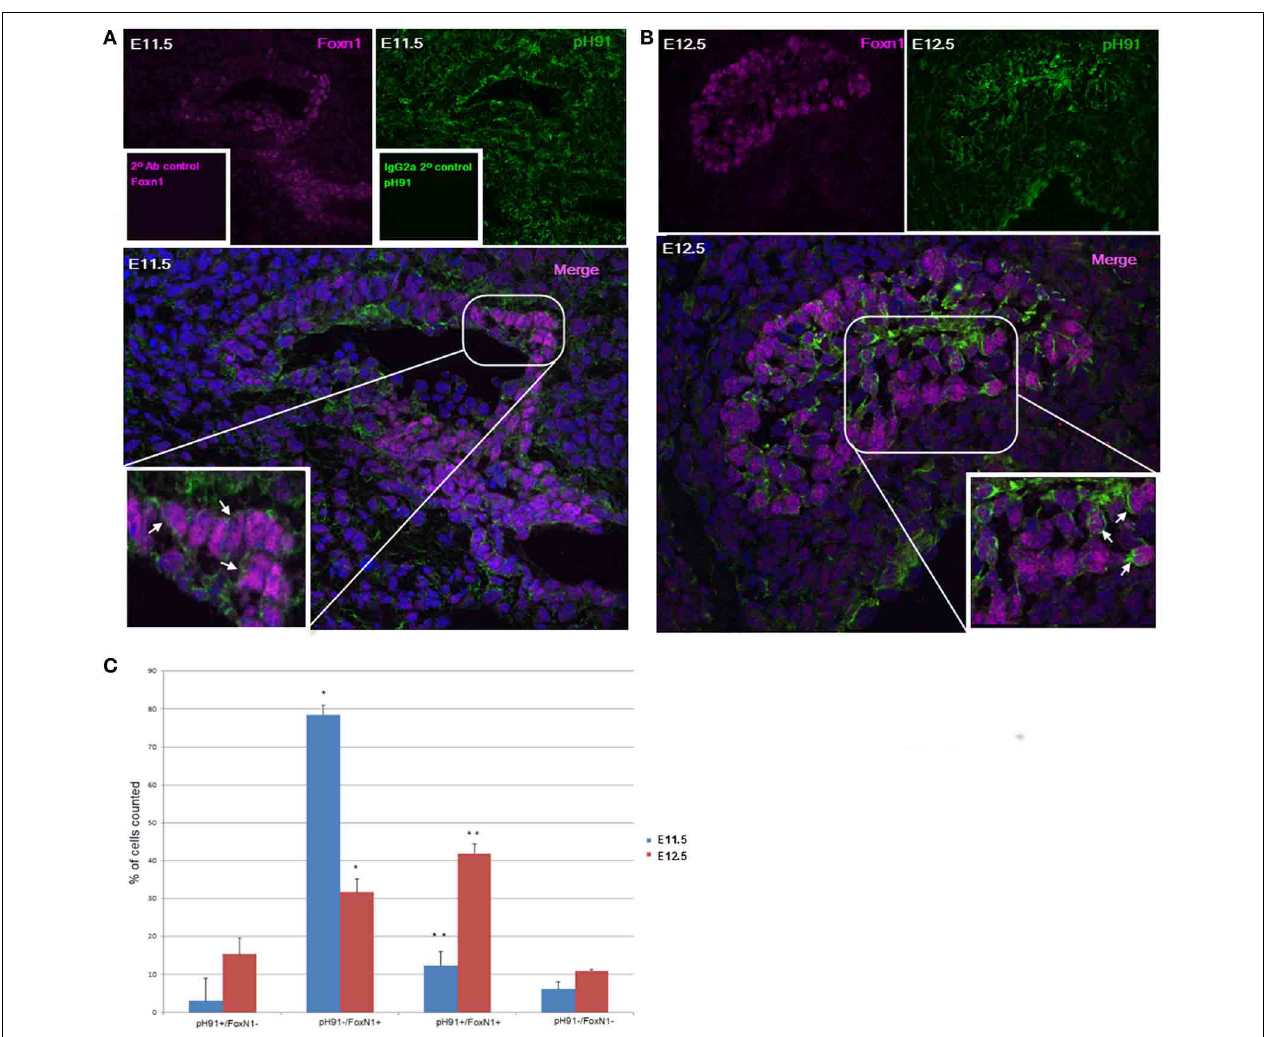
FIGURE 2 | Thymic embryonic sections stained with pH91 and anti-Foxn1 antibody. (A) shows embryonic staining with anti-Foxn1 antibody (magenta), left panel; along with pH91 (green) right panel of E11.5 mouse thymic primordium. Expression of Foxn1 is localized toward the ventral region of the embryo whereas pH91 expression is seen throughout the entire thymic and para-thyroid primordium. The merged image (lower panel) and inset (enlarged) show pH91 + cells in association with Foxn1 + cells (arrows). The insets of the upper left (inset) and upper right (inset) panels show secondary antibody control for Foxn1 antibody (magenta) and IgG2a isotope control for pH91 (green). (B) shows staining